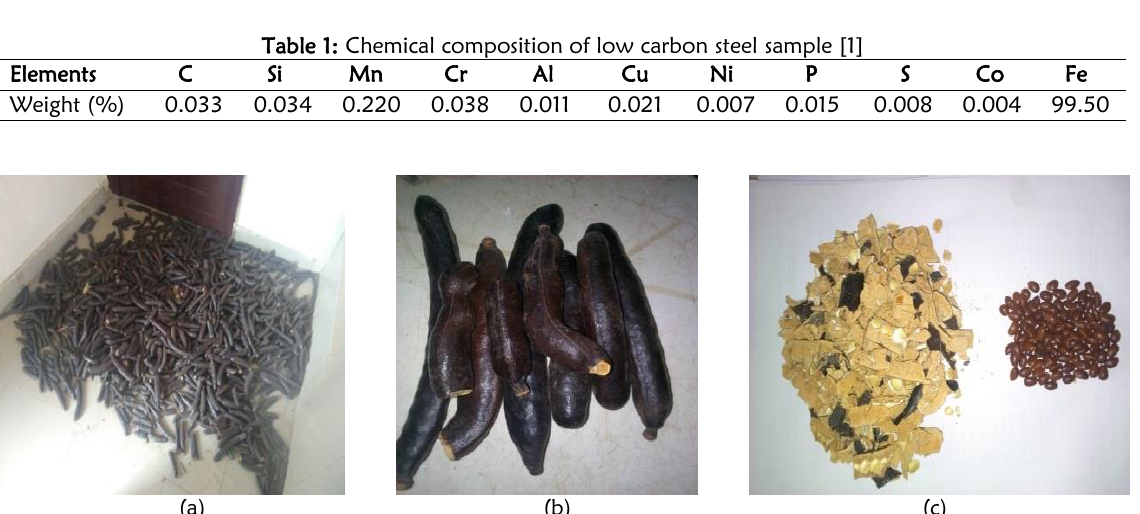
Figure 1: Prosopis Africana, (a) Pond (b) Shell after removing seeds from the pond (c)